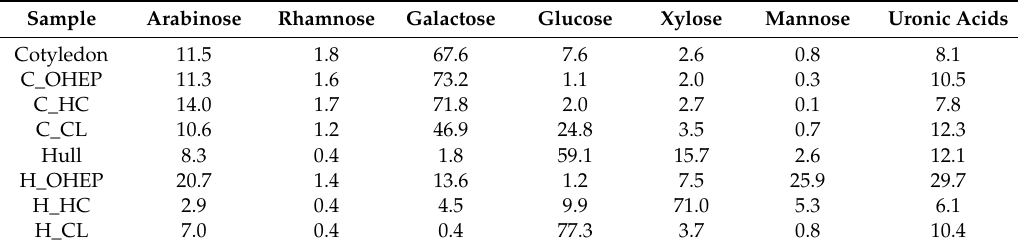
Table 2. Monosaccharide composition of cotyledon, hull and isolated pectin-like fraction (OHEP), hemicellulose fraction (HC), and cellulose-lignin fraction (CL) of L. angustifolius L. Boregine, expressed as a percentage of total polysaccharide